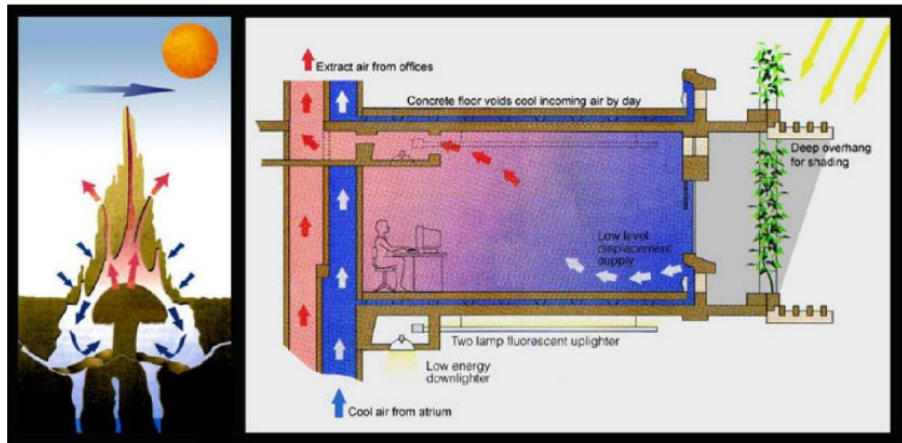
Figure 2. section of a termite-inspired building that can cool itself ( Left ), Heat circulation in a room and a termite hill ( Right ) (Source: